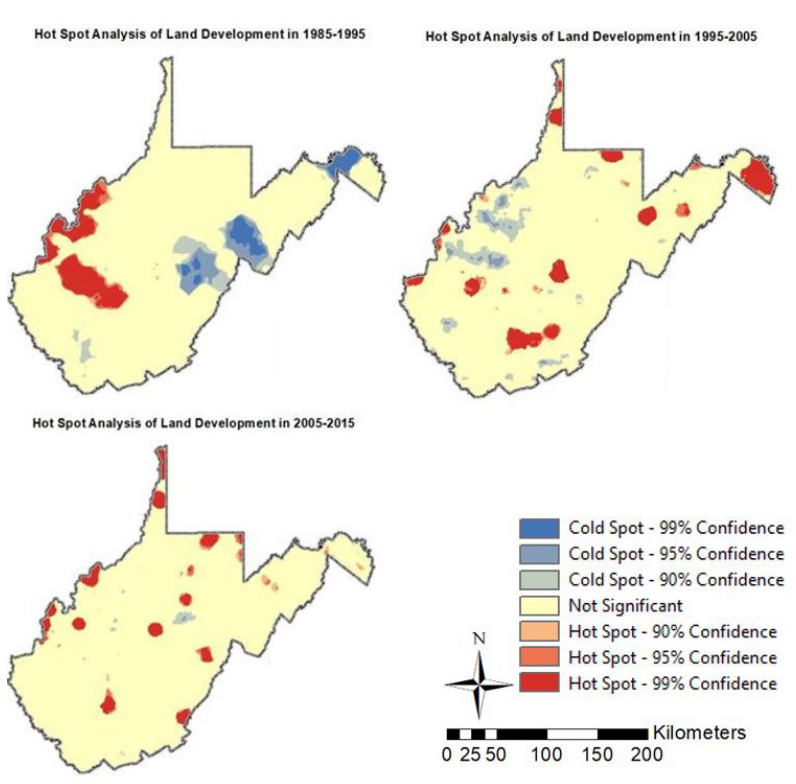
Figure 5. Hot Spot analysis of land development per